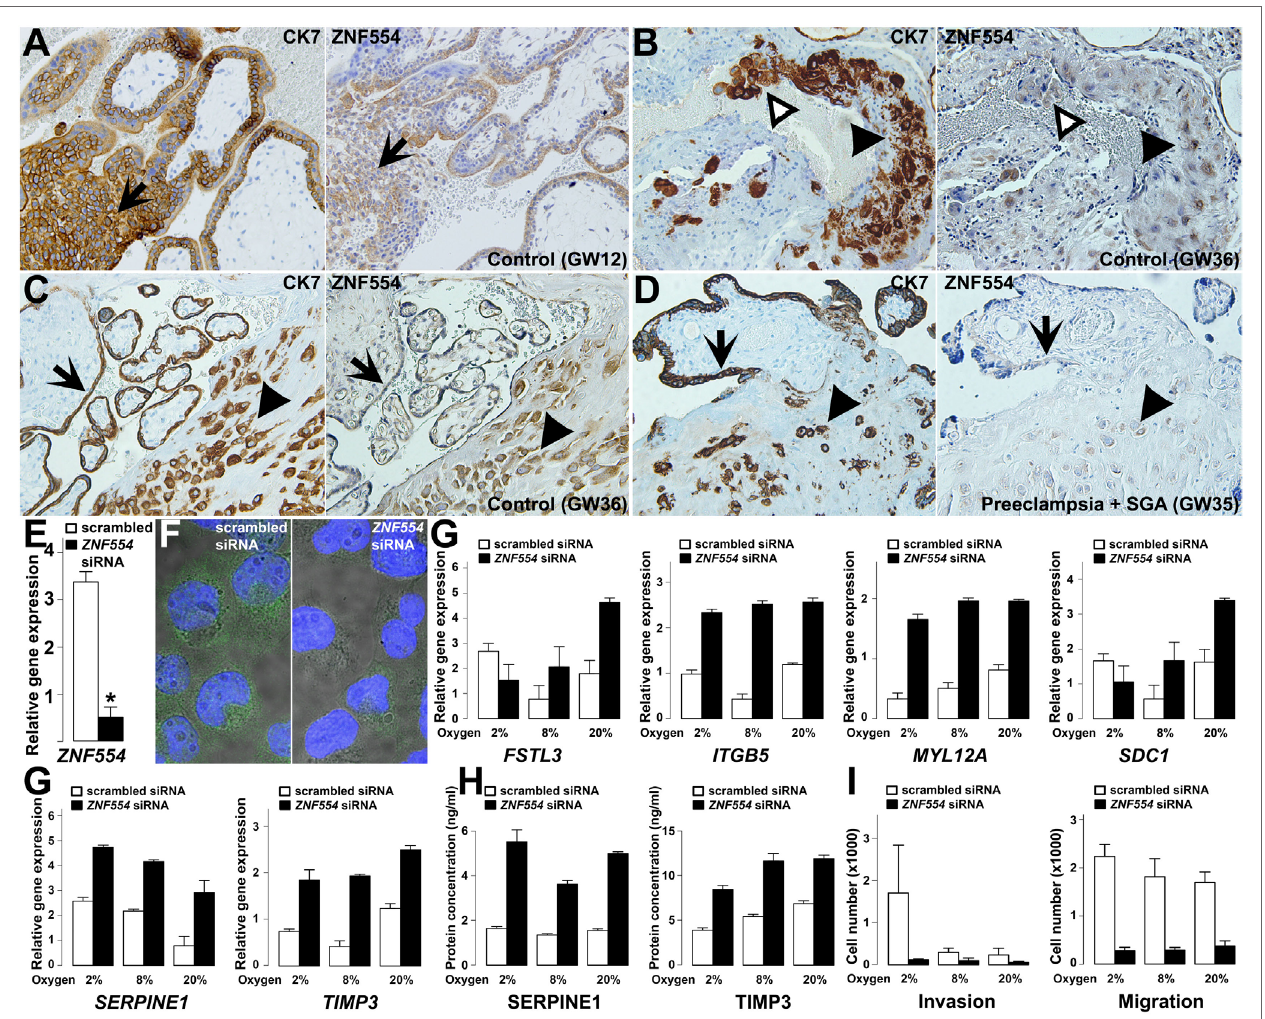
FigUre 10 | ZNF554 down-regulation in extravillous trophoblasts (EVTs) in preeclampsia. (a) EVTs in trophoblastic columns and (B) endovascular and intraluminal trophoblasts in the myometrium were immunostained for cytokeratin-7 (left) and ZNF554 (right). Arrows depict the direction of trophoblast invasion, black and white arrowheads point to EVTs in the wall and lumen of the spiral artery, respectively (serial sections, hematoxylin counterstaining, 200 × magnifications). ZNF554 immunostaining in EVTs (arrowheads) and syncytiotrophoblast (arrows) was weaker in (D) preeclampsia than in (c) controls (serial sections, hematoxylin counterstaining, 200 × magnifications). (e) ZNF554 mRNA expression decreased to 13% upon knock-down ( p < 0.001), (F) ZNF554 immunofluorescence was weaker in the nucleus and cytoplasm of ZNF554 -silenced (left) than of control (right) HTR8/SVneo cells (3,500 × magnifications). (g) The dysregulation of selected genes upon ZNF554 knock-down was confirmed by qRT-PCR. (h) Plasminogen activator inhibitor-1 (PAI-1 / SERPINE1) and TIMP-3 proteins were increasingly secreted from ZNF554 -silenced cells. (i) ZNF554 -silenced cells had remarkably decreased invasive (left) and migratory (right) characteristics. O 2 concentrations are shown below the